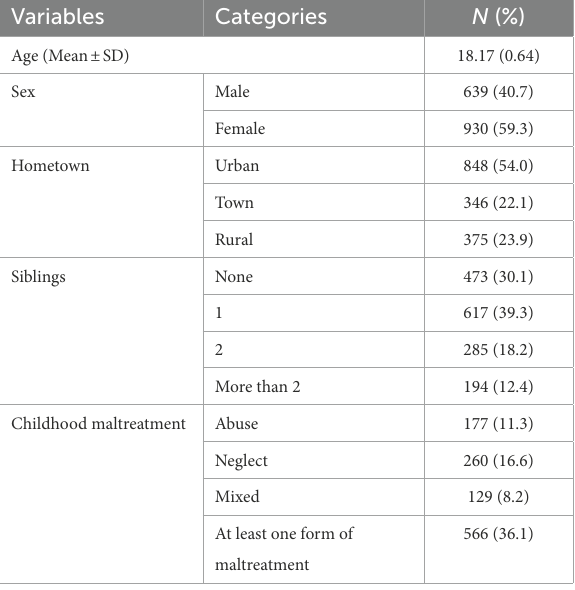
TABLE 1 Socio-demographic characteristics of the full sample ( N =